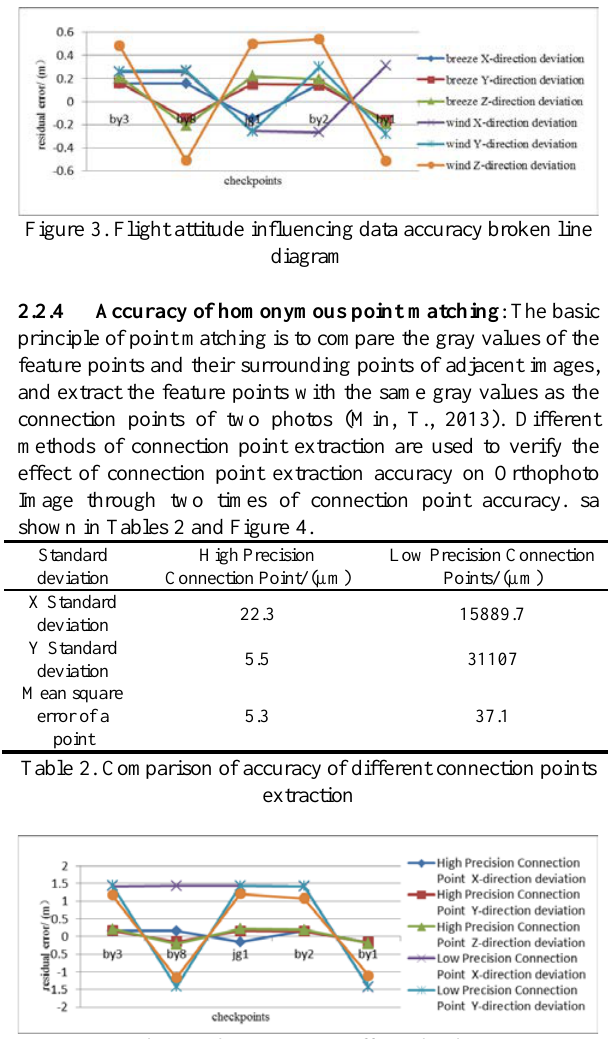
mapping. Figurer. 7: Scheme Ⅲ and Scheme Ⅳ are designed to illustrate that the number of image control points is large, but the mapping accuracy is not necessarily